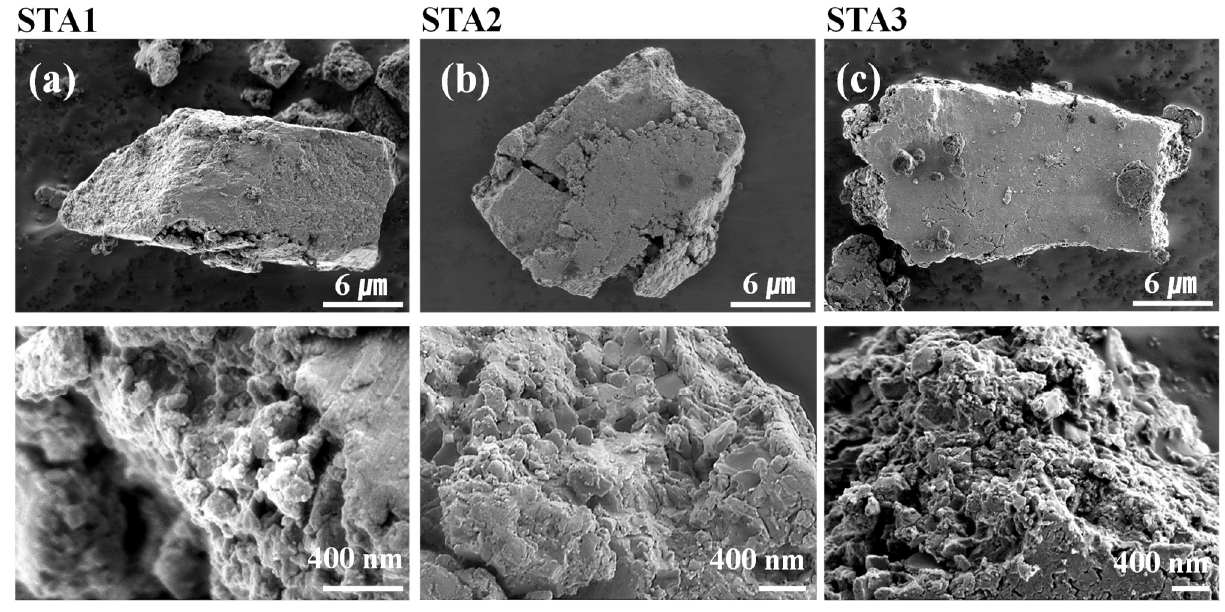
Figure 2. SEM images of ( a ) STA1, ( b ) STA2, and ( c ) STA3.